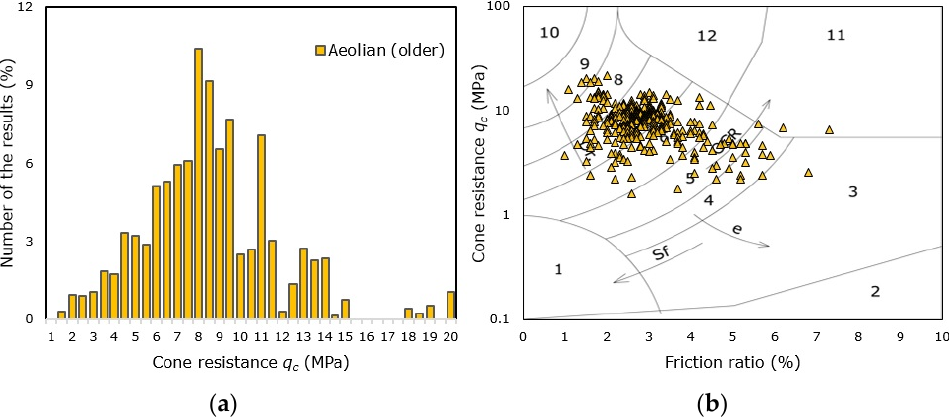
Figure 9. Summary of results for the older aeolian facies: ( a ) distribution of qc values and ( b ) sounding parameters plotted against Robertson’s chart (1—sensitive fine grained; 2—organic material; 3—clay; 4—silty clay to clay; 5—clayey silt to silty clay; 6—sandy silt to clayey silt; 7—silty sand to sandy silt; 8—sand to silty sand; 9—sand; 10—gravely sand to sand; 11—very silty fine grained; 12—sand to clayey sand; D r —density ratio; OCR—overconsolidation ratio; Sf—sensitivity factor; e—void ratio).